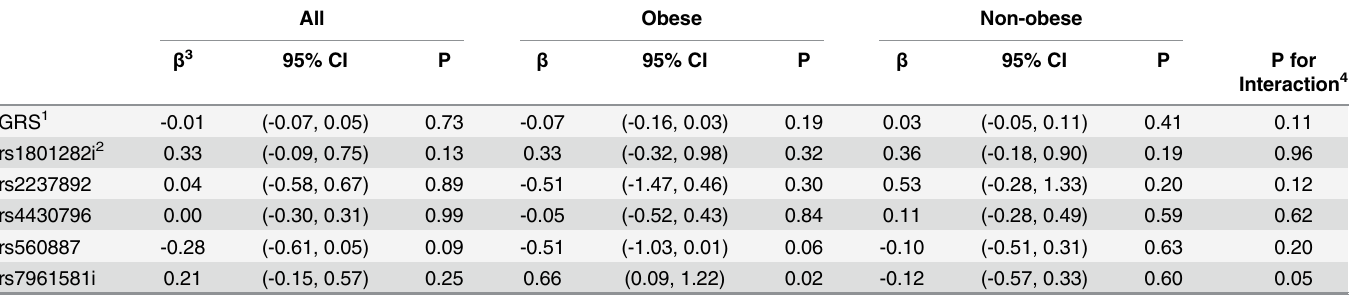
Table 3. Association between genetic risk score and selected SNPs in relation to gestational weight gain in the DNBC. All